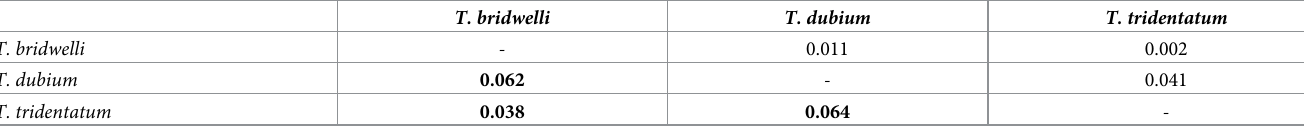
Table 4. Pairwise comparison of niche overlap using Pianka´s measure. Values of quantitative Sorensen index are in